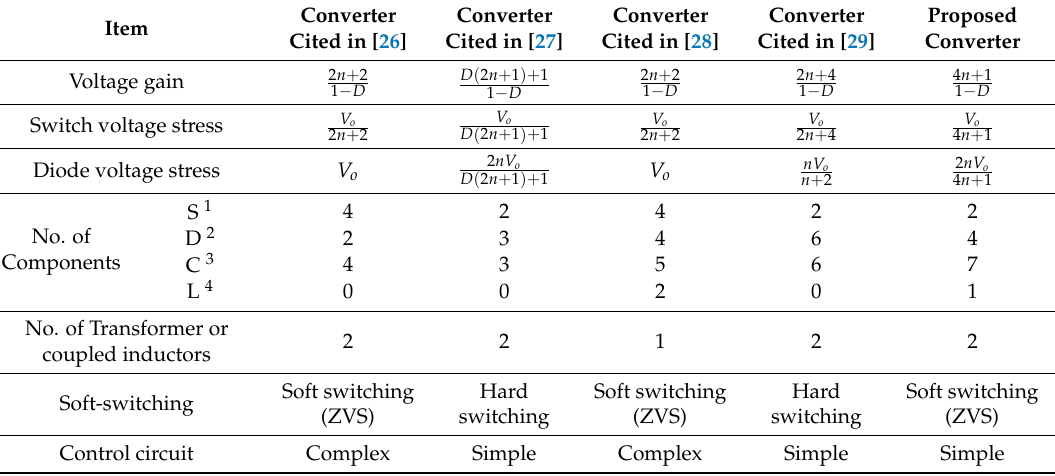
Table 1. Performance comparison among proposed converter and other